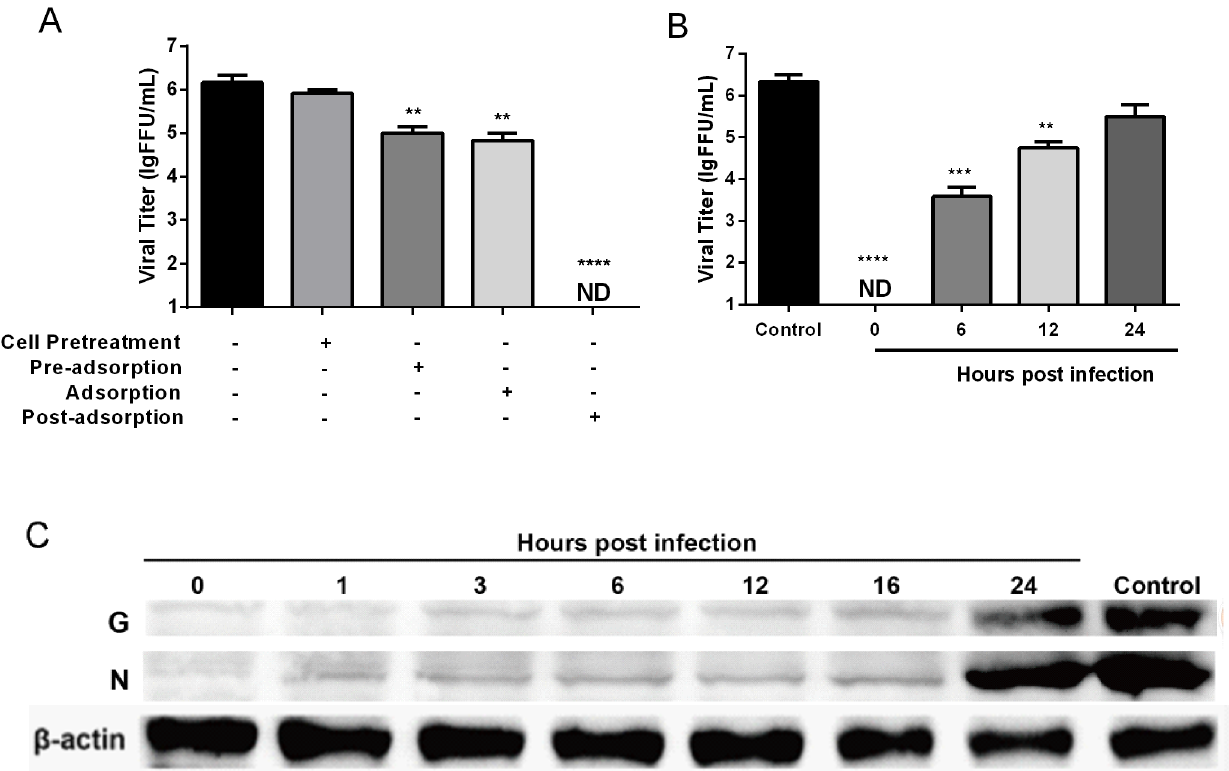
Fig 4. Inhibitory effects of P32 on RABV infection when administered under different conditions. (A) Inhibitory effects of P32 administered in the cell pre-treatment, pre-adsorption, adsorption, and post-adsorption stages. (B) Inhibitory effects of P32 administered at different time points during the viral post- adsorption period. SK-N-SH cells were infected with SAD-L16-eGFP (MOI = 0.01) and exposed to 250 μ g/mL P32 in MM at the indicated time points. Culture supernatants were harvested at 48 hpi for virus titration. Each value is expressed as the mean ± SEM from three independent experiments ( ** , P < 0.01; *** , P < 0.001; **** , P < 0.0005, ND means non-detectable). (C) Detection of nucleoprotein (N) and glycoprotein (G) levels of RABV by Western blot in RABV- infected cells that were treated with P32 at different time points during the viral post-adsorption period. NA cells were treated with 250 μ g/mL P32 at the indicated time points after infection with the RABV strain SAD-L16 at an MOI of 0.01. At 48 hpi, cells were collected and lysed for Western blot analysis.